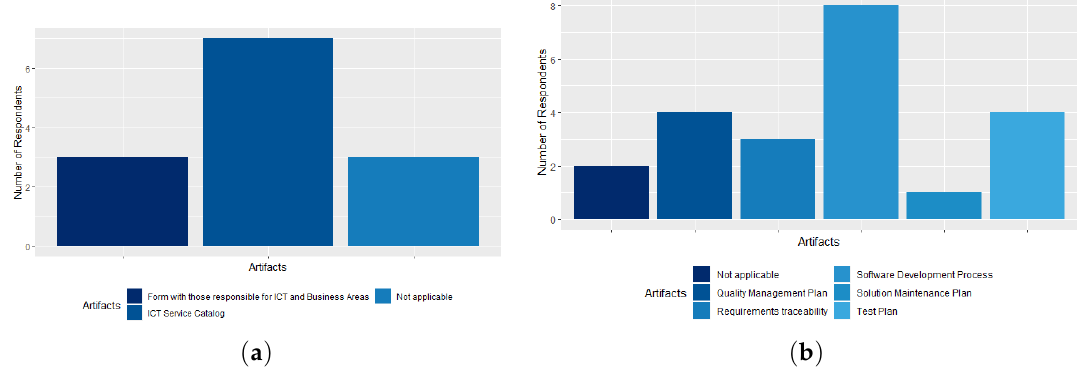
Figure 8. ( a ) The Computerized Systems Catalog (ICT Services Catalog) process artifacts; ( b ) the Software Development (Quality Management, Configuration) process